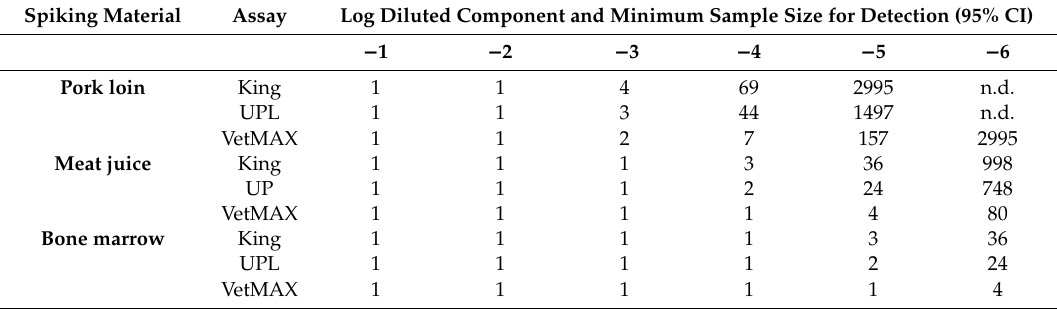
Table 4. Minimum sample size to detect a single infected animal per homogenous product. Spiking